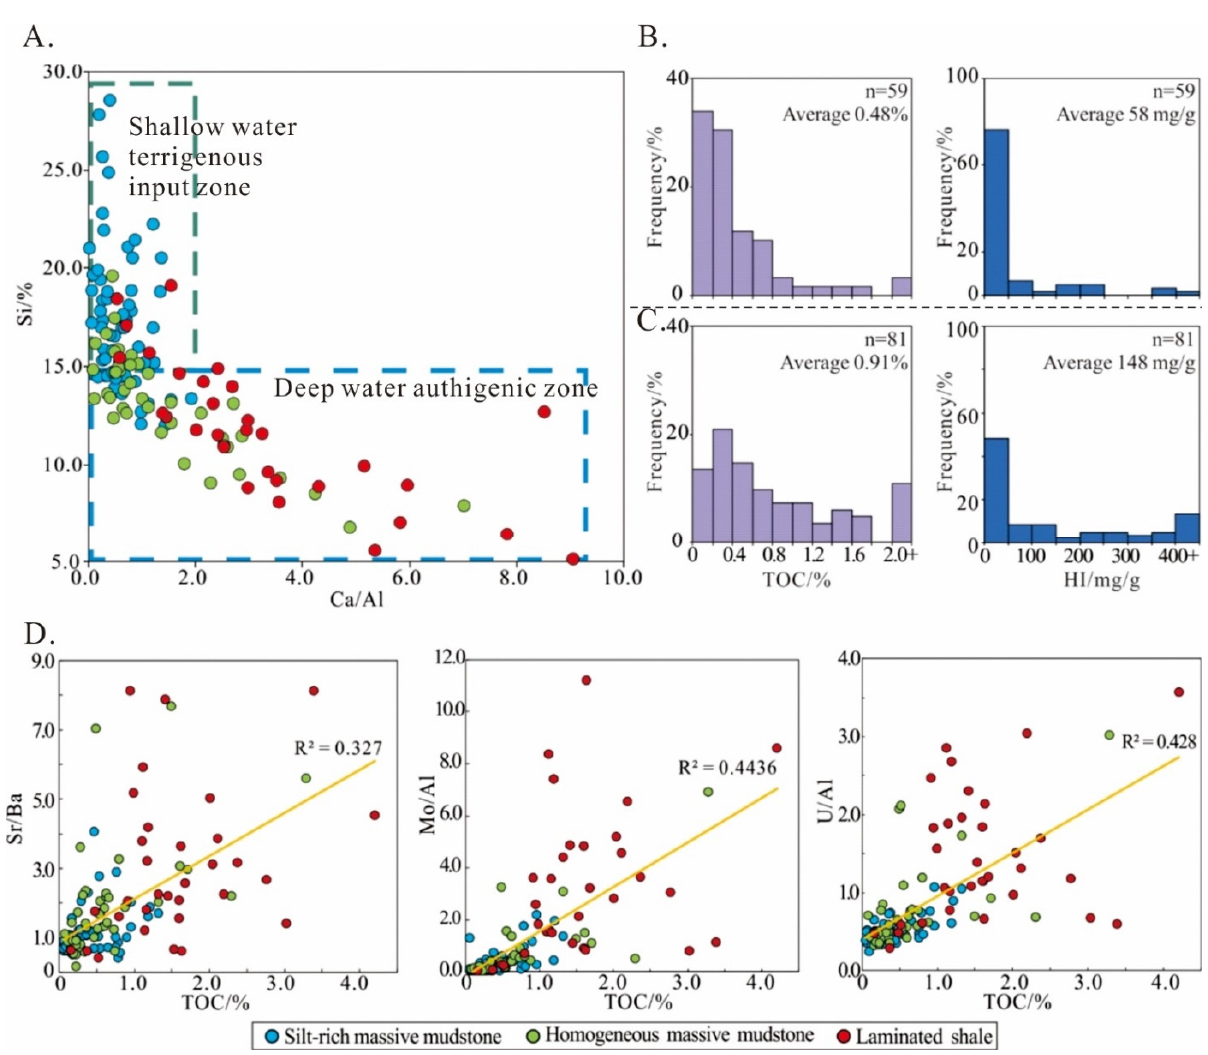
Figure 6. Geochemical proxies and correlation chart of each lithofacies. ( A ) Si-Ca/Al chart; ( B ) TOC and HI value distribution histogram of the shallow water terrigenous input zone; ( C ) TOC and HI value distribution histogram of the deep water authigenic zone; ( D ) salinity and palaeoredox proxies—TOC correlation plot of the lithofacies.